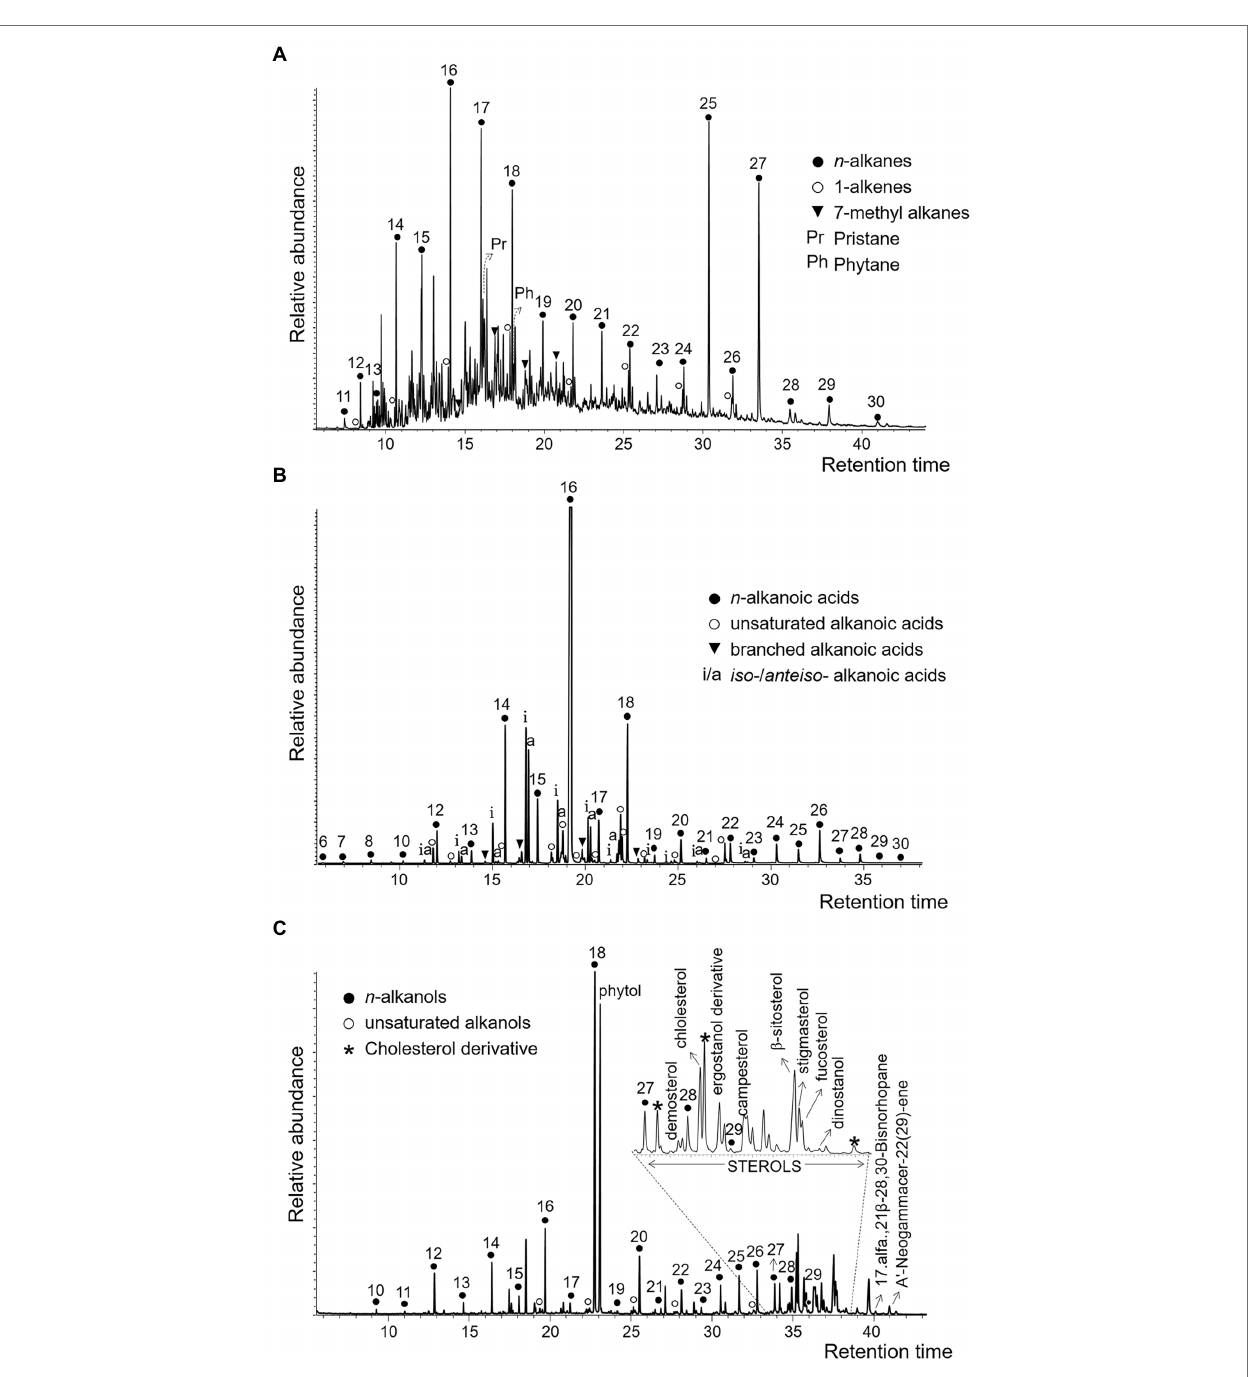
FIGURE 7 | Partial ion chromatograms of the three polarity fractions of lipids in the ancient microbial mat; non-polar (A) , acidic (B) , and polar (C) . Hydrocarbons in (A) were measured in the m/z = 57 ion, alkanoic acids in (B) , in the m/z = 74 ion, and alcohols in (C) , in the m/z = 75 ion. In the three panels, numbers over the peaks indicate carbon chain lengths of the straight-chain or normal series (i.e., n -alkanes, n -alkanoic acids, and n -alkanols). In (B) , iso -/ anteiso - pairs (marked as i/a over the peaks) refer to branched alkanoic acids with a methyl group in positions N-1 or N-2,